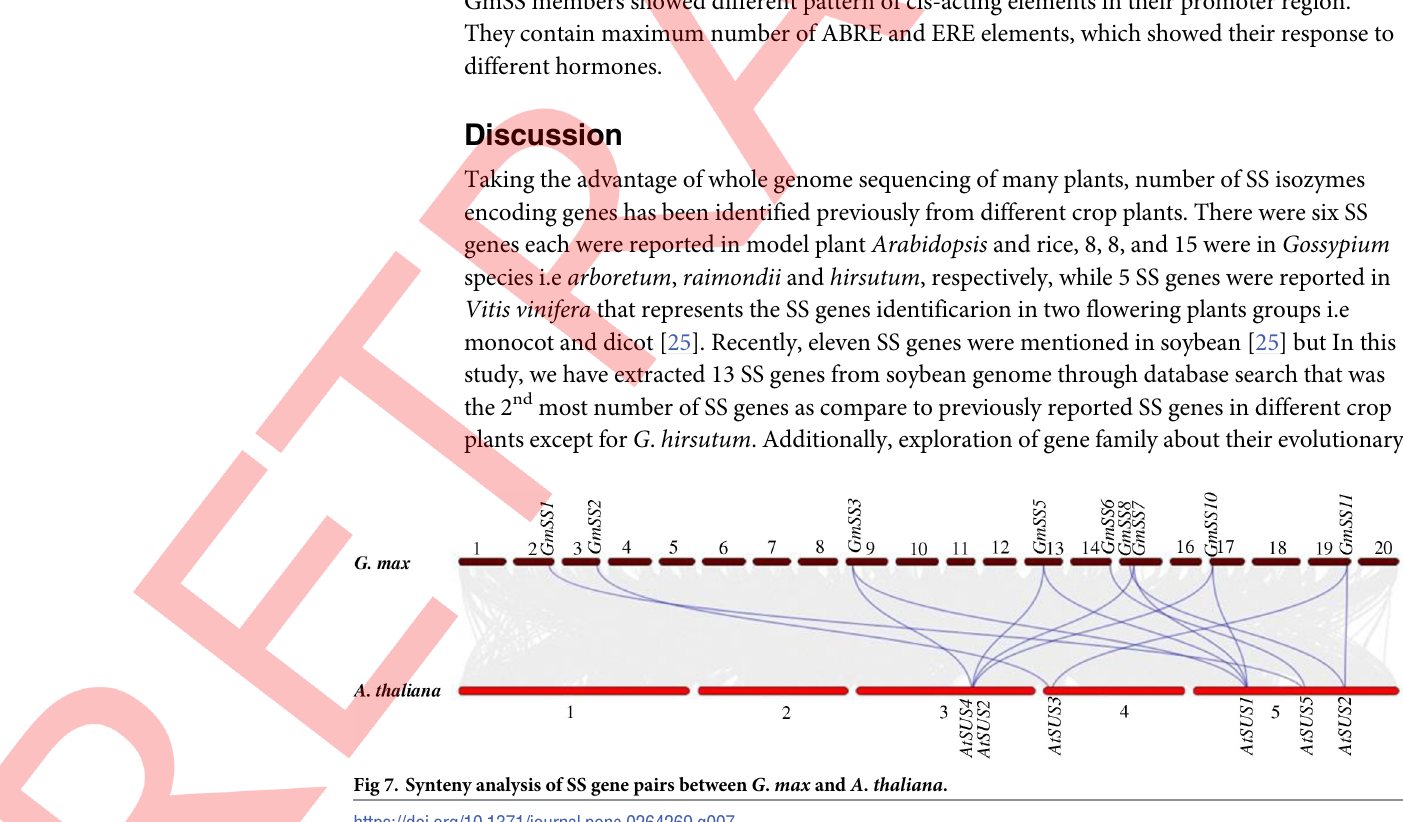
Fig 7. Synteny analysis of SS gene pairs between G . max and A . thaliana